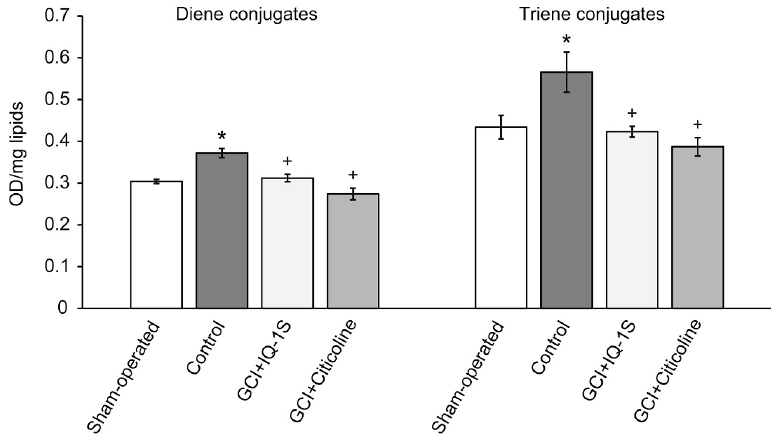
Figure 3. E ff ects of IQ-1S (50 mg / kg, i.g.) on contents of diene conjugates (OD 232 / mg of lipids) and triene conjugates (OD 270 / mg of lipids) in the brain tissue in rats at day 5 after GCI. * p < 0.05 as compared Figure 3. Effects of IQ-1S (50 mg/kg, i.g.) on contents of diene conjugates (OD 232 /mg of lipids) and with the sham-operated animals; + p < 0.05 as compared with the triene conjugates (OD 270 /mg of lipids) in the brain tissue in rats at day 5 after GCI. * р < 0.05 as compared with the sham-operated animals; + р < 0.05 as compared with the control.